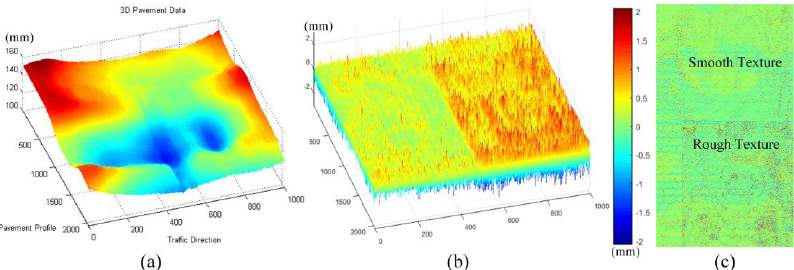
Figure 17. Vibration components and the corresponding pavement texture information, ( a ) 3D pavement data; ( b ) corresponding vibration component; ( c ) rough and smooth texture information.